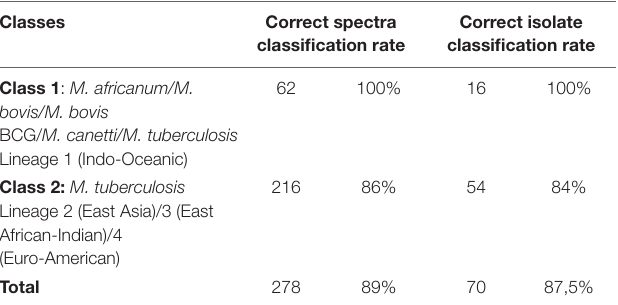
TABLE 5 | Correct classification rates for spectra and isolates from test group isolates according to QC2. Classes Correct spectra Correct isolate classification rate classification rate